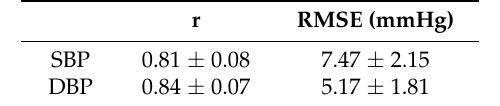
Table 2. Group average correlation coefficients and root-mean-squared-errors (RMSEs) between estimated systolic BP (SBP) and diastolic BP (DBP) from the proposed device and the standard device.